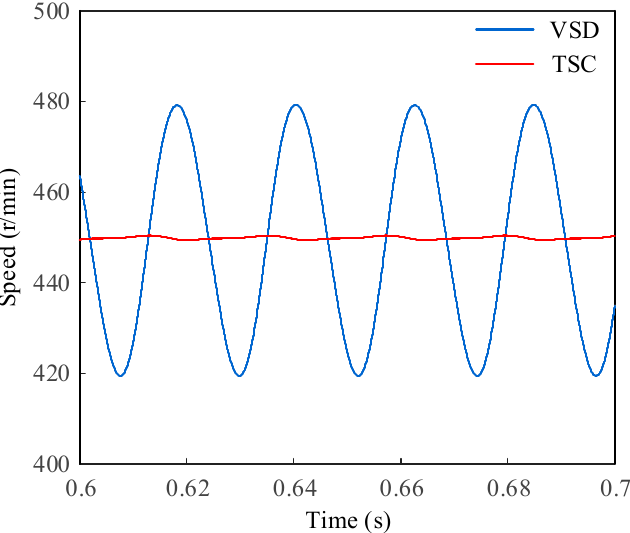
Figure 6. Speed waveforms of the non-fault-tolerant decoupling control and the TSC fault-tolerant control.